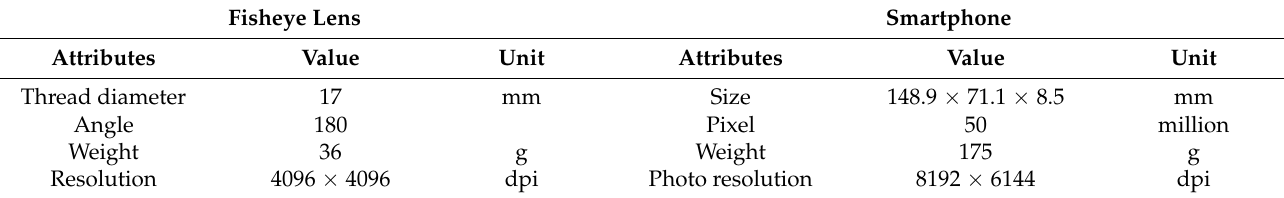
Table A2. Measuring equipment